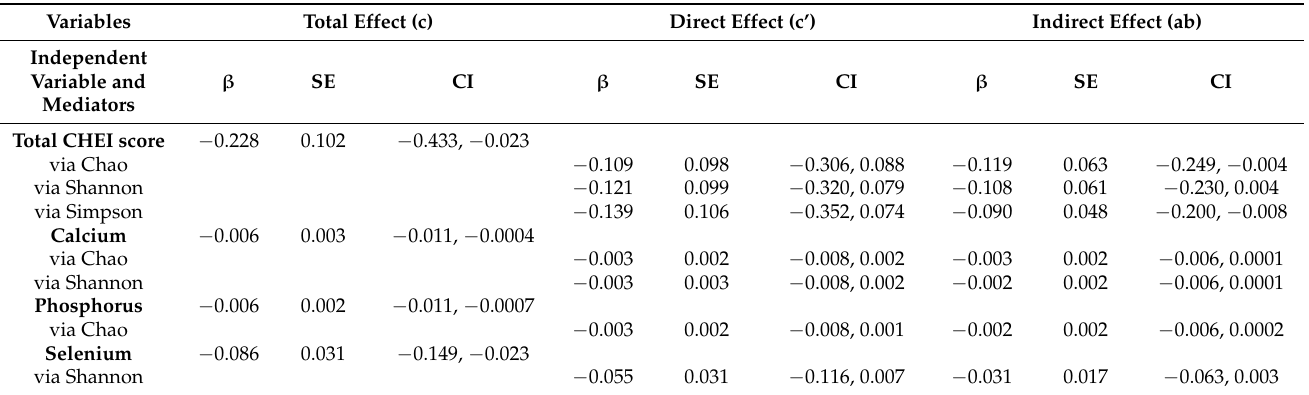
Table 4. Total, direct and indirect effects of diet on the CES-D score with the gut microbiota as a mediator in breast cancer participants ( n =